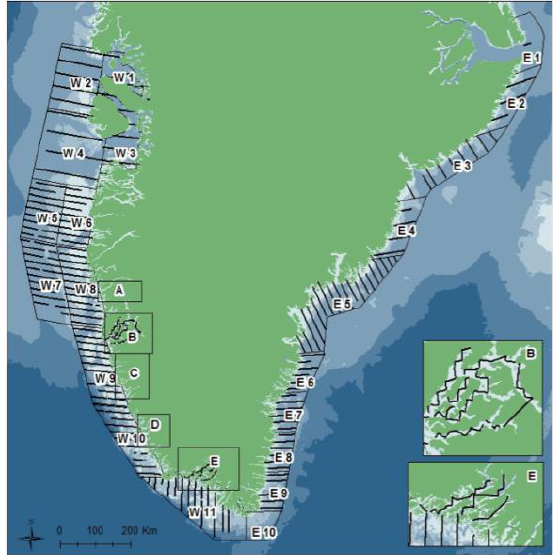
Figure 1. Survey effort in sea state <5 in East and West Greenland with delineation of strata and depth contours indicated (2,000m, 1,000 m, 200m and 100m). Block A (strata 12-18), B (strata 19), C (strata 20-25), D (strata 26-29) and E (strata 30-35). Block A, C and D were not